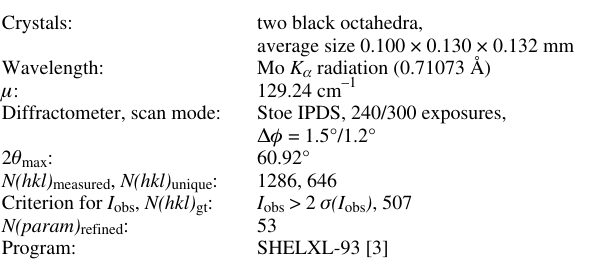
Table 5. Data collection and handling.